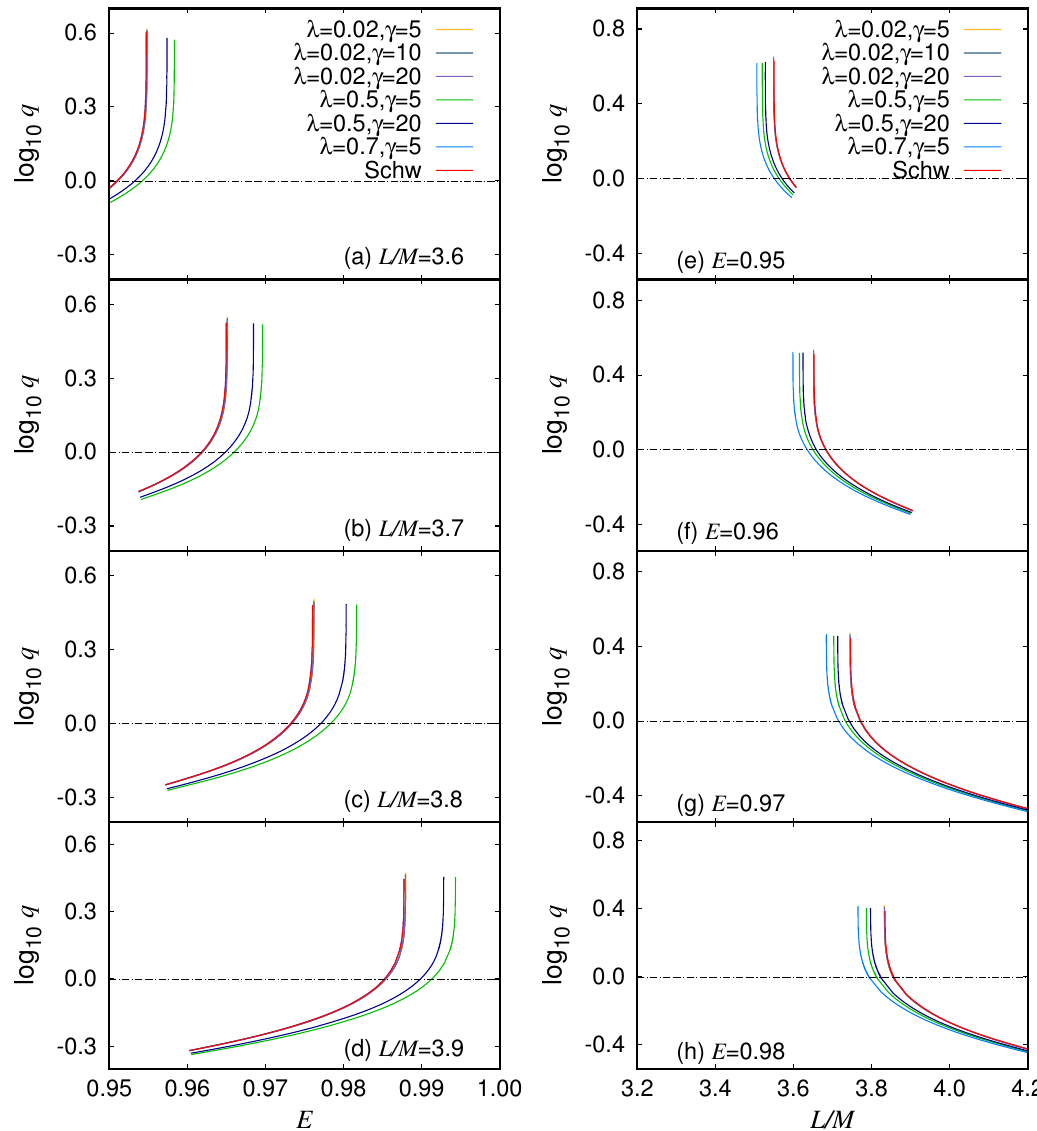
Figure 7. q versus E (left panel) and q versus L / M (right panel) with different parameters values. In summary, for the quasi-periodic and periodic orbits with the same values of L / M and E around RGISBHs, it is indicated that: (1) the variations in the values of λ and γ make a transition from one periodic orbit to one quasi-periodic one and vice versa; (2) the behaviors of quasi-periodic orbits are quite different with the change of the parameters λ and γ ; (3) the bound orbits around RGISBHs in the strong gravitational field are quite different from the Schwarzschild